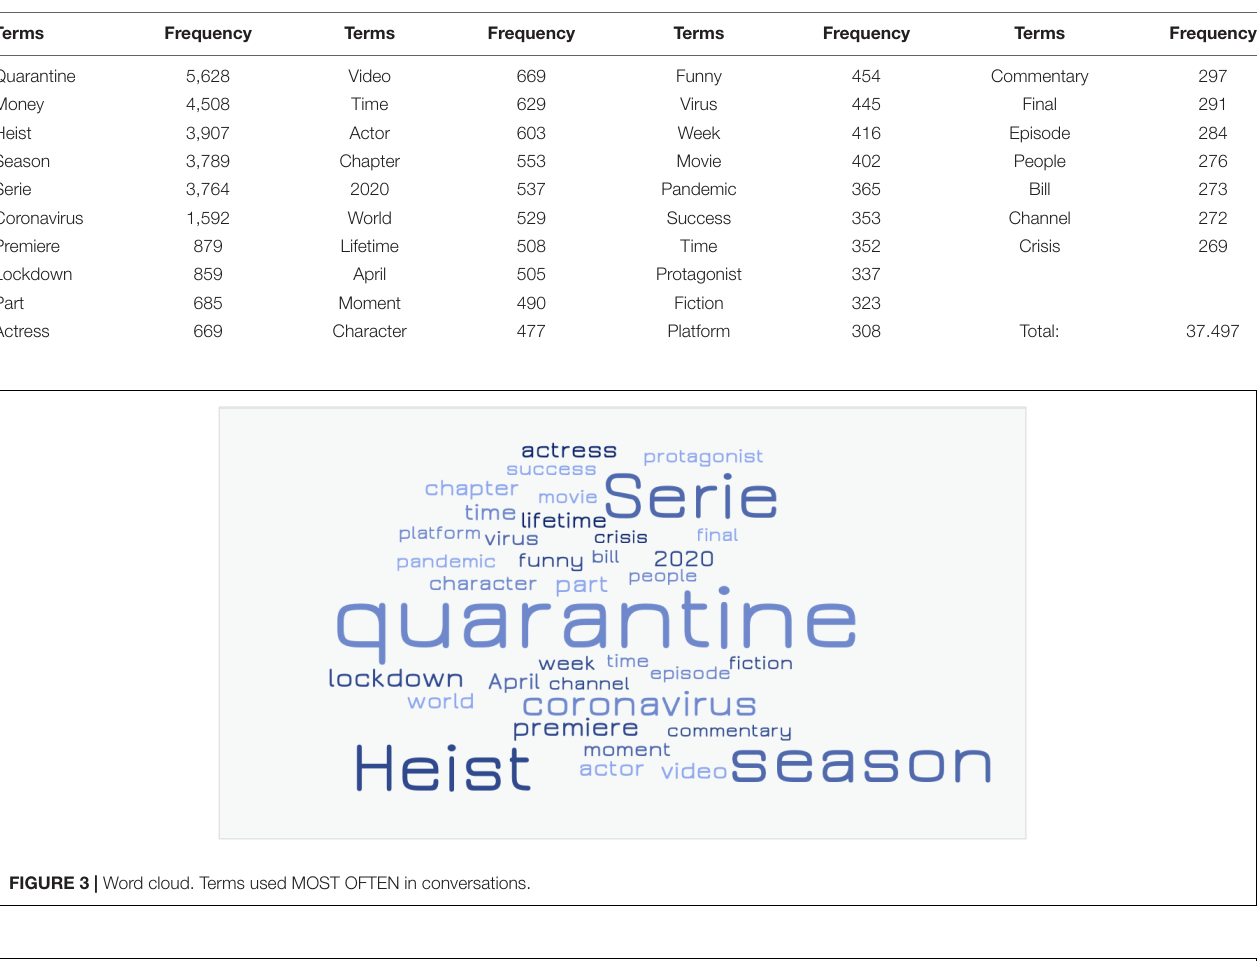
TABLE 3 | Frequency of the most used terms in conversations.